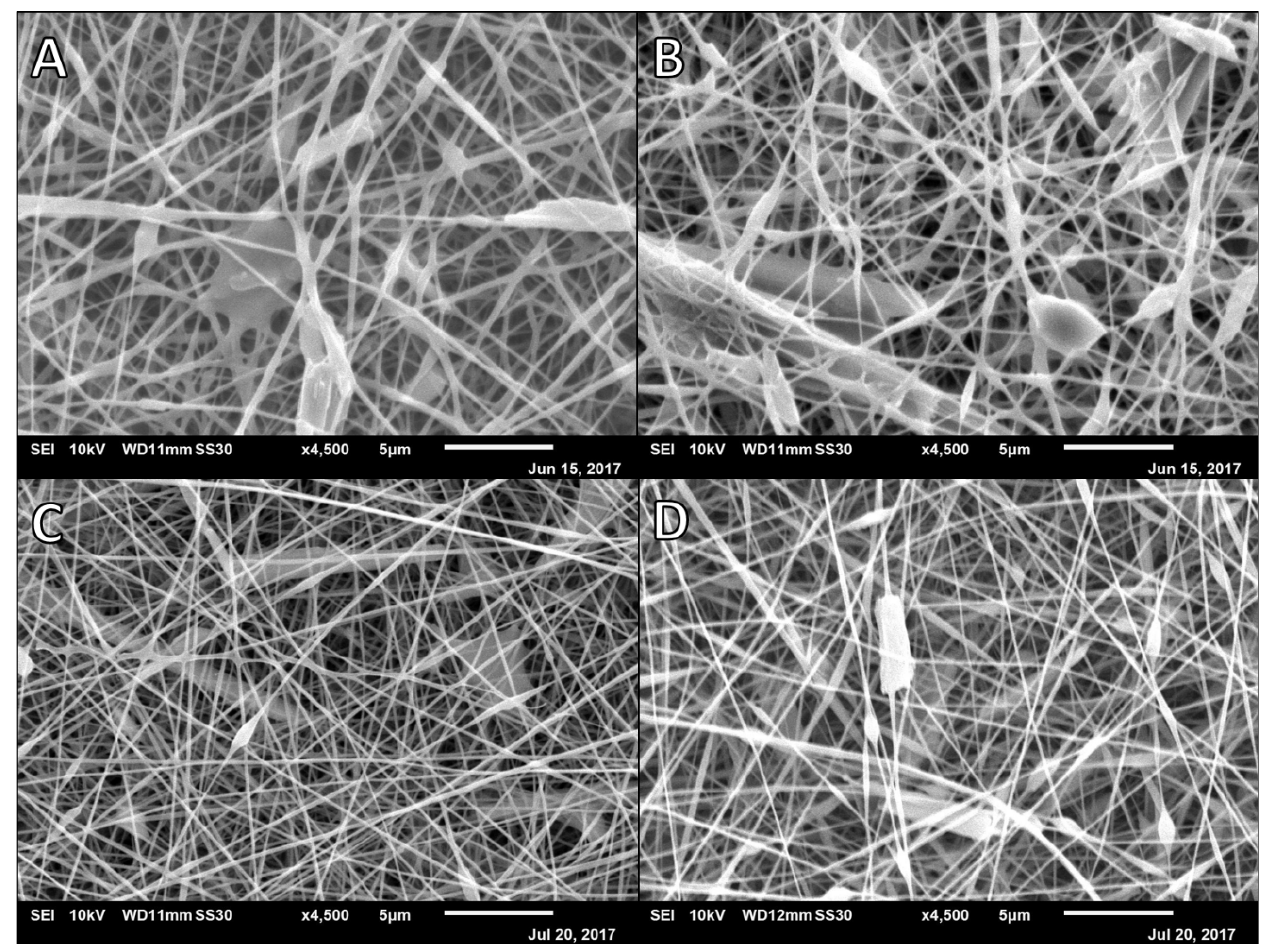
Figure 6. SEM micrographs of drug-loaded 3:7 2.5% Alg:10% PVA nanofibers at 100 mm, 1 mL disp. ( A ) 5% Ciprofloxacin (Cipro) at 7.5 μL/min and 19 kV; ( B ) 5% Cipro at 9.8 μL/min and 20 kV; ( C ) 4% Cipro at 7.5 μL/min and 20 kV; and ( D ) 4% Cipro at 9.8 μL/min and 15 kV. 3.5 and 3% ( w/v ) while maintaining the same alginate and PVA concentrations and